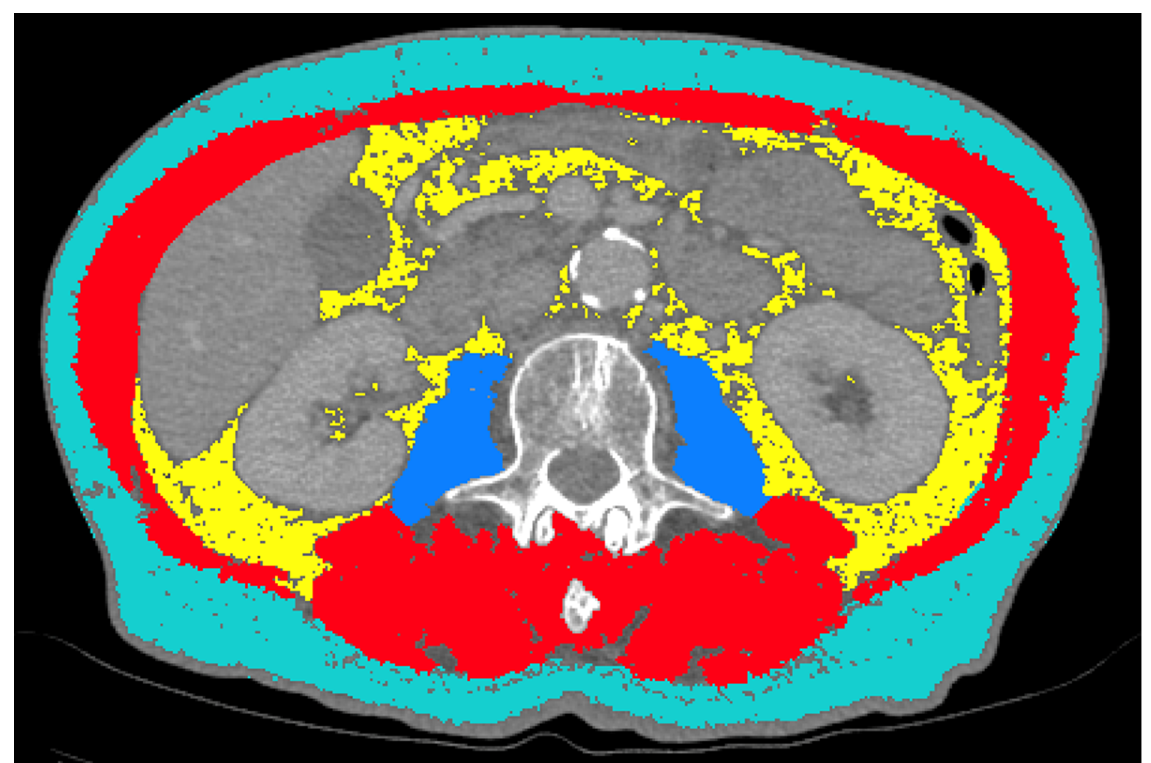
Figure 1. Example of semiautomated segmentations of subcutaneous adipose tissue (SAT; turquoise), visceral adipose tissue (VAT; yellow), psoas muscle area (PMA; blue) and total abdominal muscle area (TAMA, red + blue) at the L3 level.